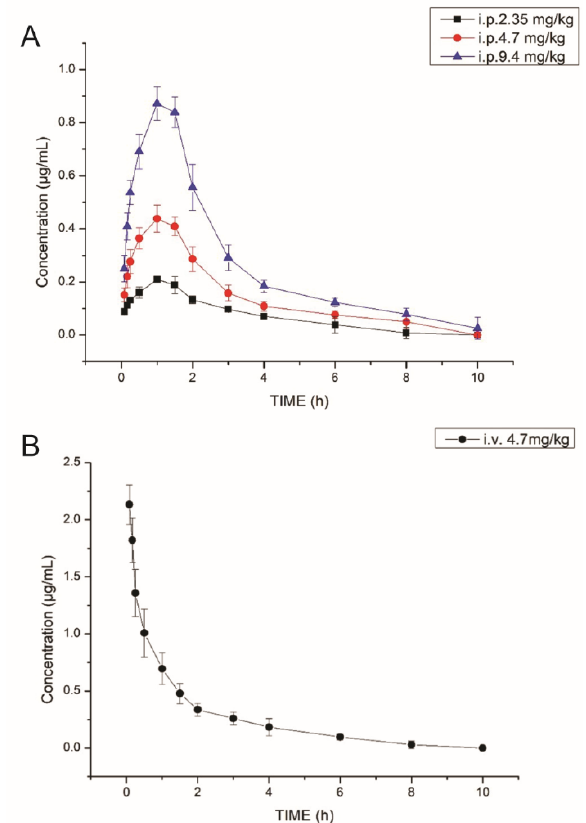
Figure 3. Plasma concentration time curves of intraperitoneal ( A ) and intravenous ( B ) administration. n = 6. The i.p. and i.v. indicate intraperitoneal injection and intravenous injection, respectively.